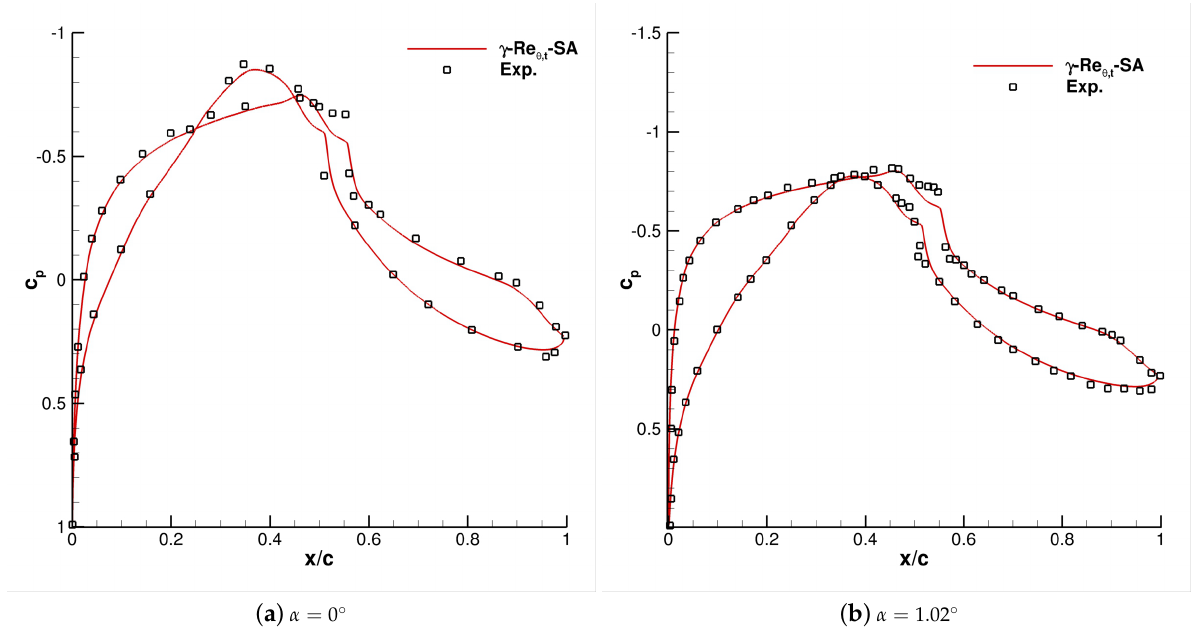
Figure 6. S809, Re = 2 × 10 6 . Pressure coefficients.